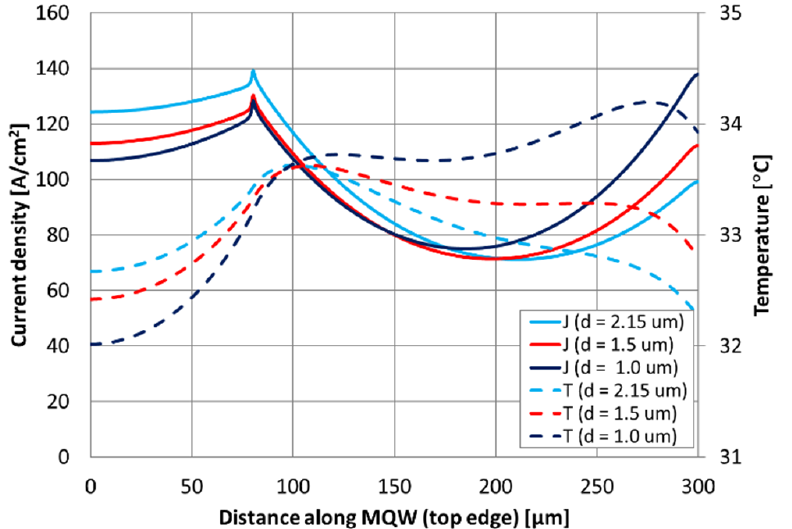
Figure 12. Current density distribution (continuous lines) and temperature distribution (dashed lines) along the top edge of the MQW layer for three thickness values of the n-GaN:Si layer.